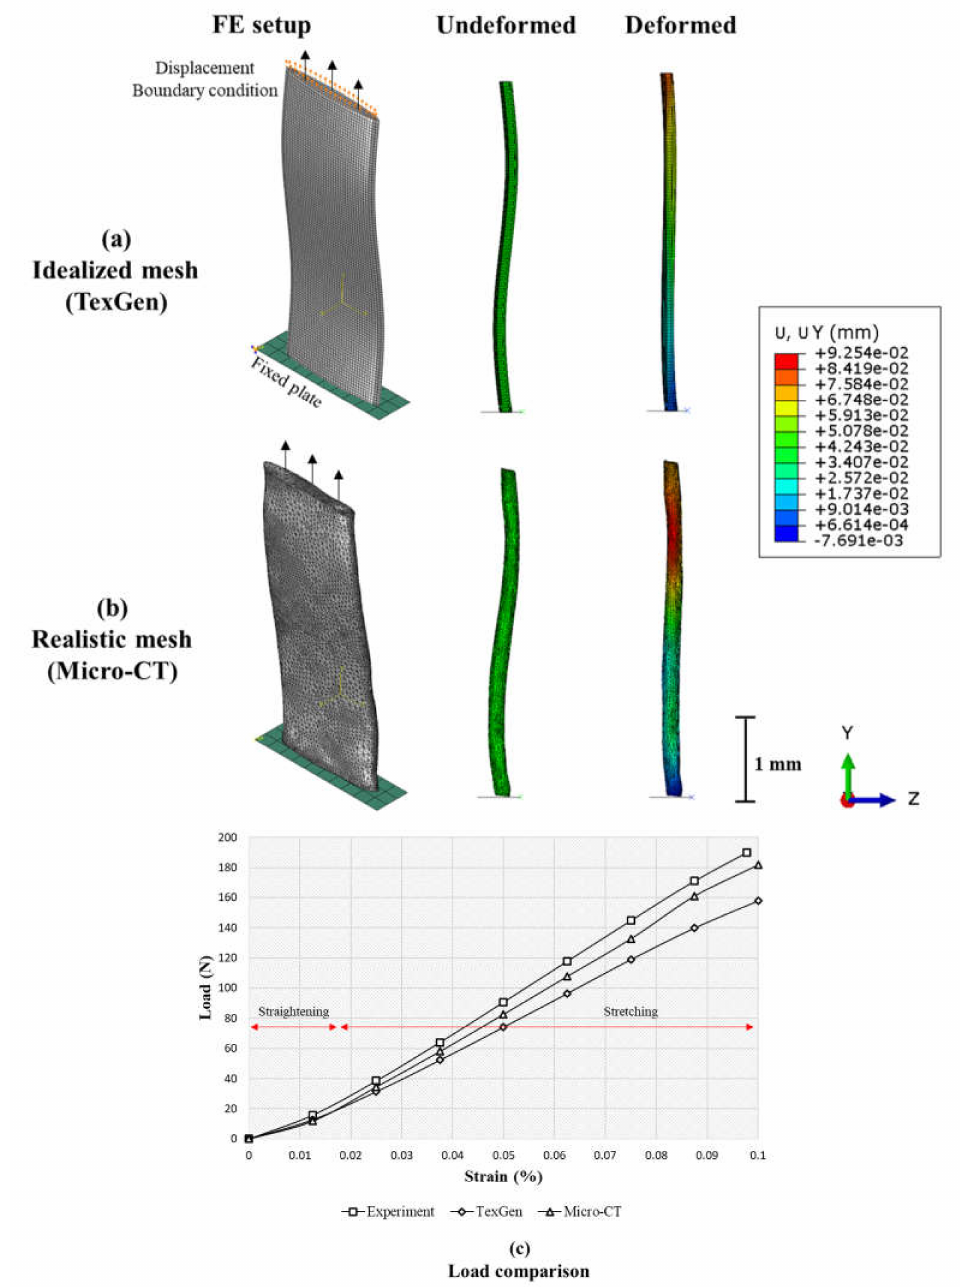
Figure 15. Uniaxial loading Finite element (FE) simulations: ( a ) Idealized mesh generated via Texgen software ( b ); Generated FE mesh using triangular elements for the dry woven fabric case accounting for the structural variations. ( c ) Comparison between the load response up to 0.1% strain for all three cases. The onset of stretching is also shown in the